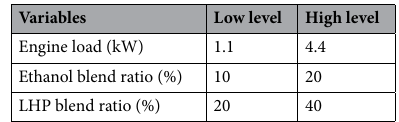
Table 6. Variables and levels of factorial design.